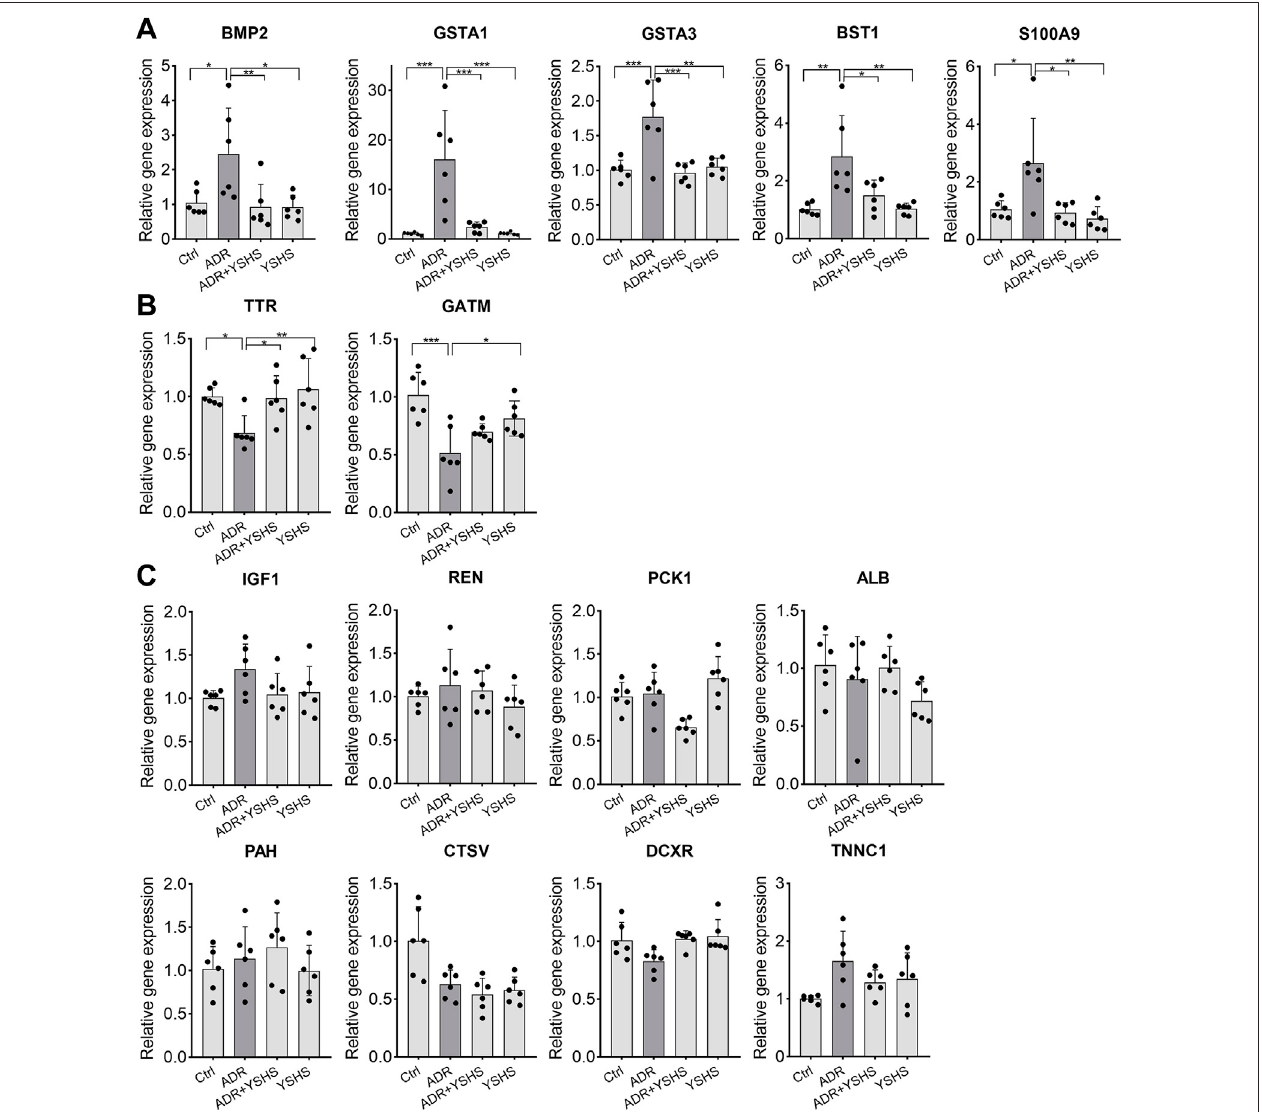
FIGURE 5 | Effects of the YSHS granule on the expression of predicted target genes in the ADR-induced FSGS model. (A – C) Real-Time PCR was performed to analyze the expression of these predicted targets. YSHS down-regulated the expressions of Bmp2, Gsta1, Gsta3, Bst1, and S100a9 (A) , and up-regulated the expression of Ttr and Gatm (B) , while it did not affect the expressions of Igf1, Ren, Pck1, Alb, Pah, Ctsv, Dcxr, and Tnnc1 (C) in the ADR-induced FSGS model. N = 6 in each group, the data were shown as mean ± SD, one-way ANOVA analysis followed by Tukey post-hoc tests as appropriate for multiple comparisons, * p < 0.05, ** p < 0.01, *** p <